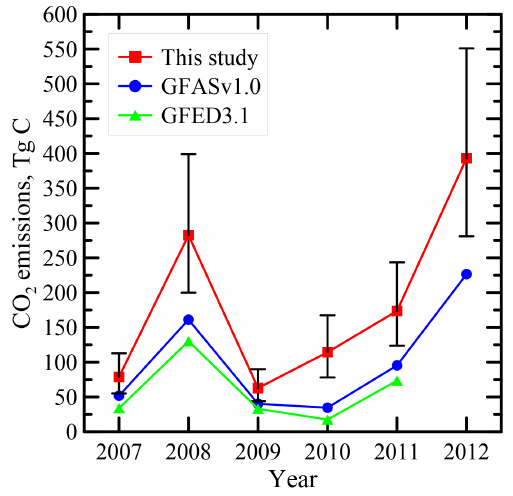
Figure 9. Annual biomass burning CO 2 emissions (TgC) in Siberia according to this study, GFASv1.0, and